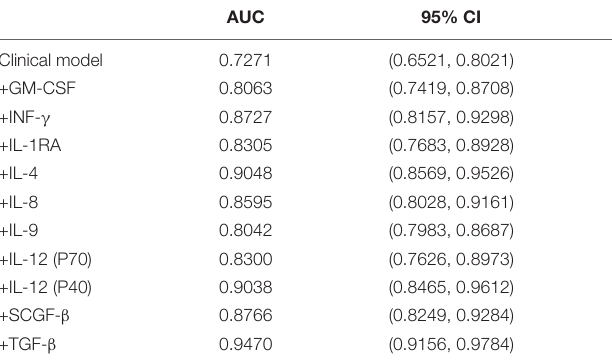
TABLE 3 | The performance of a predictive model after add a factor to clinical